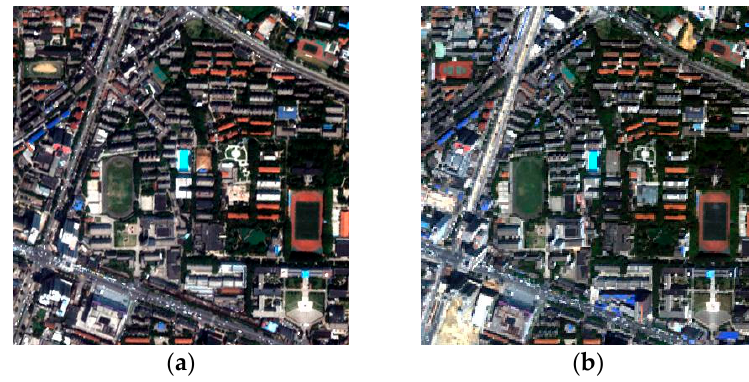
Figure 8. Degraded bi-temporal images of the first study area: ( a ) acquired by QuickBird in April 2005 (L1) and ( b ) acquired by IKONOS in July 2009 (L2).